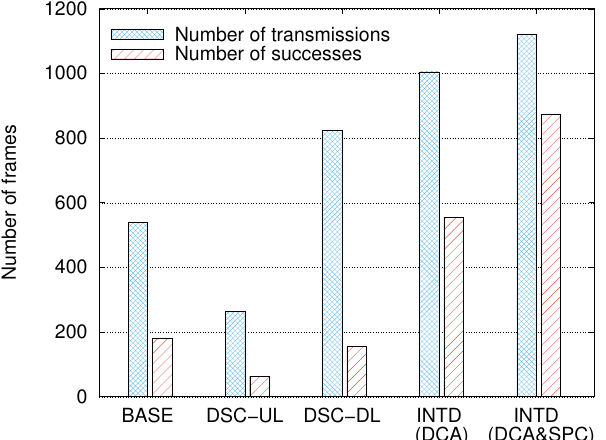
Figure 8. Comparison of number of frames transmitted by access point with number of frames successfully delivered to